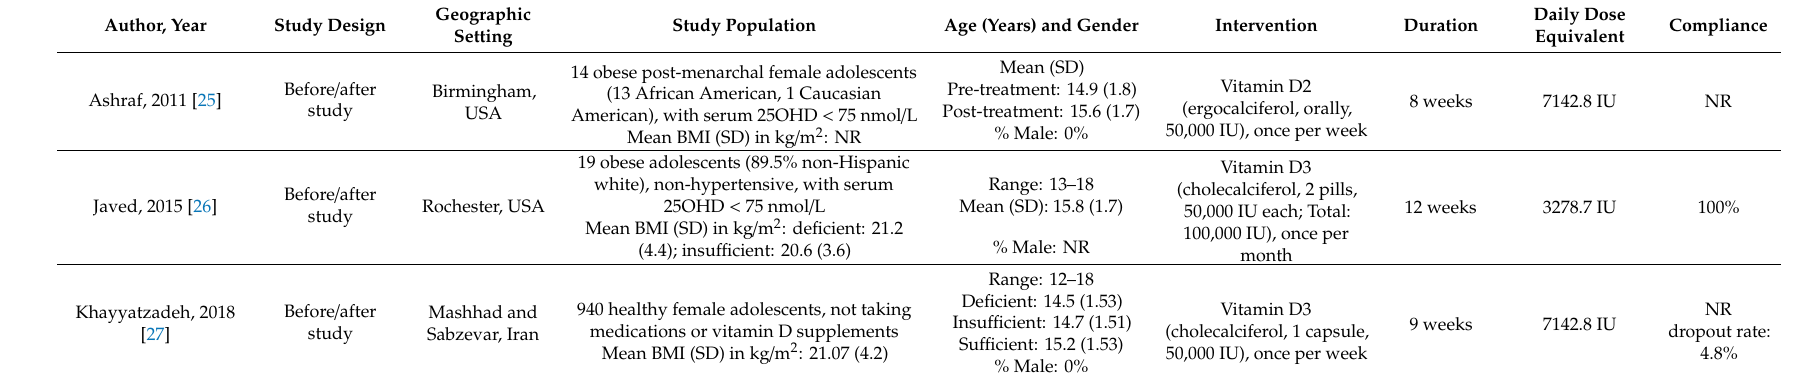
Table 1. Characteristics of non-randomized human interventions